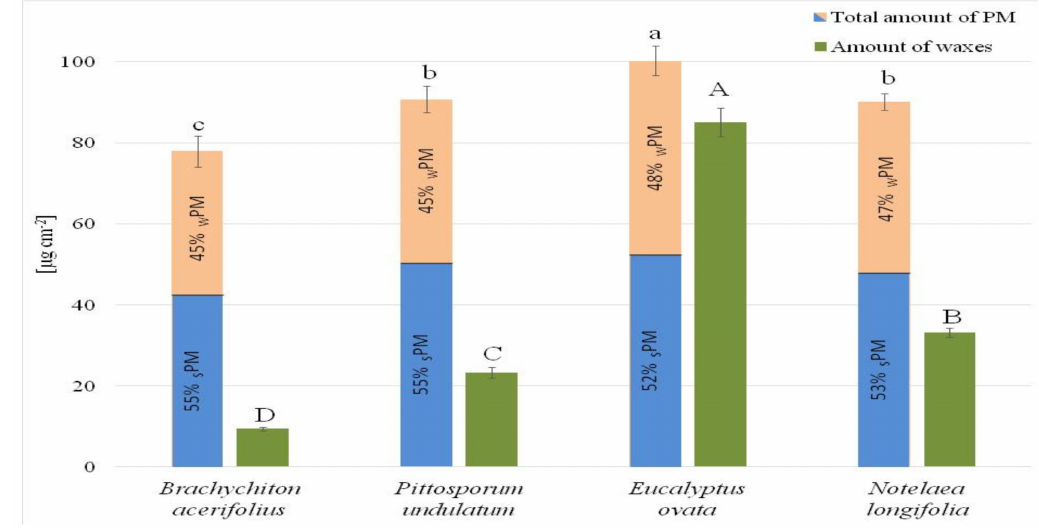
Figure 2. Average amount of PM (divided into S PM and W PM) and waxes on leaves of B. acerifolius, P. undulatum , E. ovata and N. longifolia over five weeks. PM and waxes values are expressed as µ g per cm − 2 of leaf. Data are means ± SE, n = 15. Di ff erent letters (lowercase for PM and capital for waxes) indicate statistical significance (P < 0.05).